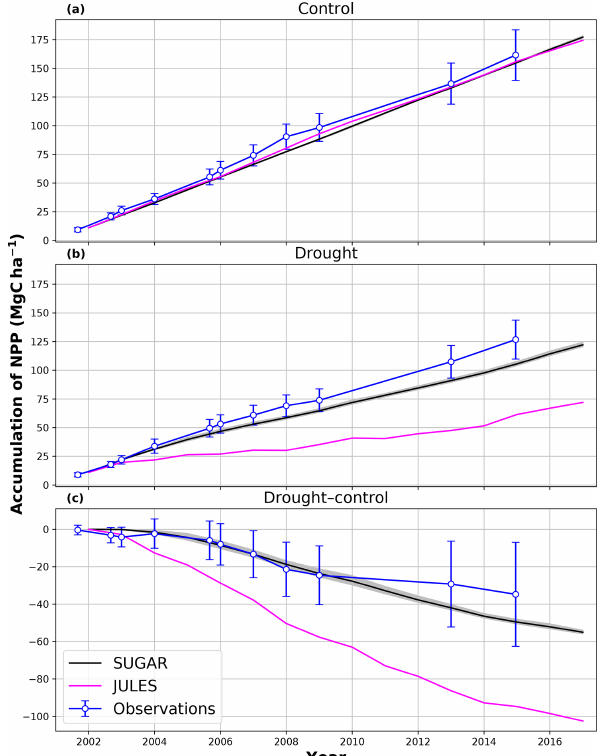
Figure 6. Net primary productivity (NPP), autotrophic respiration ( R p ) and plant carbon expenditure (PCE = NPP + R p ) for the pe- Figure 5. Accumulated net primary productivity at Caxiuanã in the riods 2002–2004, 2005 and 2009–2011. Panels (a) , (c) and (e) are (a) control plot and (b) TFE plot and (c) the difference between the from the control plot and (b) , (d) and (f) are from the throughfall drought and control forest (TFE–control). Observations are calcu- exclusion (TFE) plot. Model predictions from JULES and SUGAR lated as the accumulated sum of above-ground biomass increment are calculated by taking the mean of each flux over each period. Ob- change and total local litter fall (Rowland et al., 2018). The pre- sented confidence intervals are the sum of the litter fall measure- from 2009–2011 are from da Costa et al. (2014). Simulated ment error and the 95% confidence intervals of biomass increment calculated from eight allometric equations using trunk diameter at breast height (DBH) data from Caxiuanã. The uncertainty envelope on SUGAR represents the maximum and minimum of an ensemble of simulations in which parameter a K was varied between 0.1 and m 2.0.